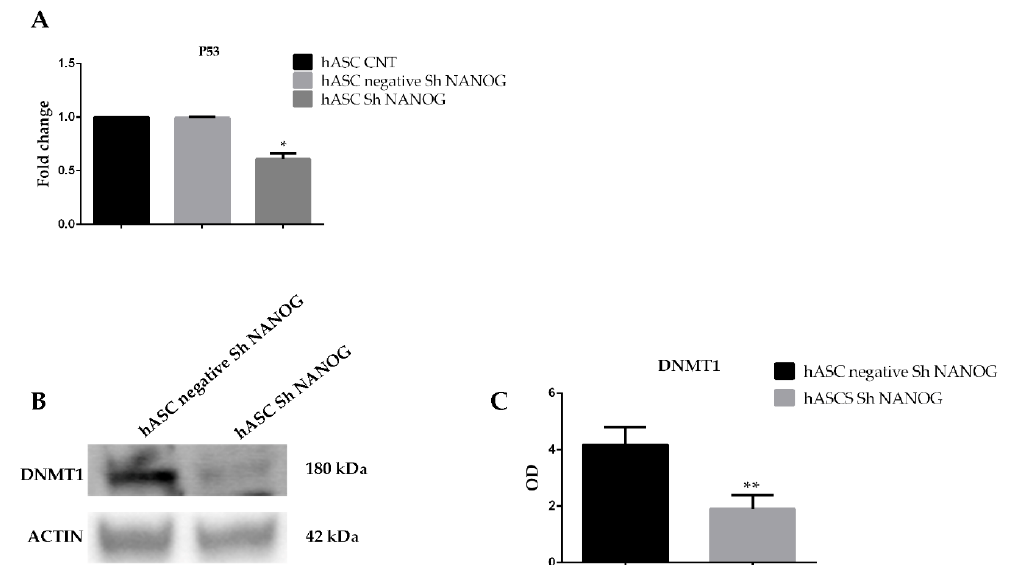
Figure 5. Changes in hASCs cell cycle distribution as a result of NANOG downregulation. ( A ) Shows cell cycle distribution of hASCs according to Nicoletti’s protocol. ( B ) and ( C ) Real-time PCR analyses showed that expression of the cell cycle protein CDKN1A and CDKN1B were significantly increased in hASCs with NANOG downregulated while the expression of CYCLINE D1 was downregulated ( D ). Flow cytometry analyses showed that downregulation of NANOG induced a decrease in the proportion of G2/M + S phase cells in hASCs sh NANOG as compared to freshly isolated hASCs at passage 4 (hASCs CNT). All experiments were repeated at least three times. (Values are mean ± SD, ** p < 0.01).